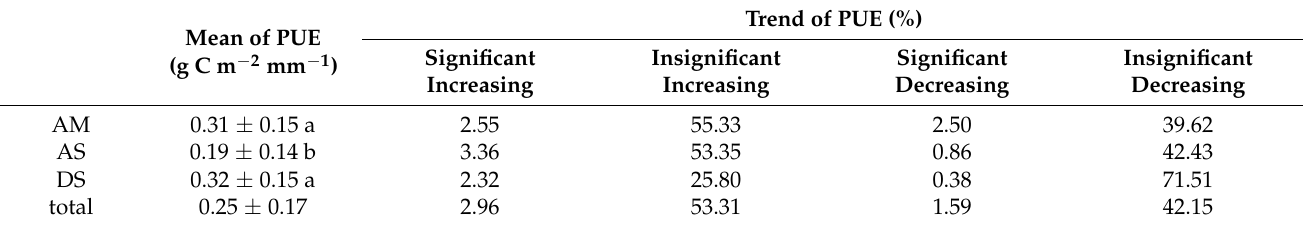
Figure 4. The spatiotemporal patterns of the PUE on the QTP. ( a ) The mean of PUE. The small map at the bottom is the dynamics of the PUE from 2000 to 2017. ( b ) The distribution of the trend in PUE. The small map at the bottom is the range of significance levels. Table 2. Percentages of grasslands with different variation trends in PUE across the whole plateau and within different grassland types from 2000 to 2017. AM, AS, and DS indicate alpine meadow, alpine steppe, and desert steppe, respectively. Different letters (a, b) denote significant differences between them ( p <